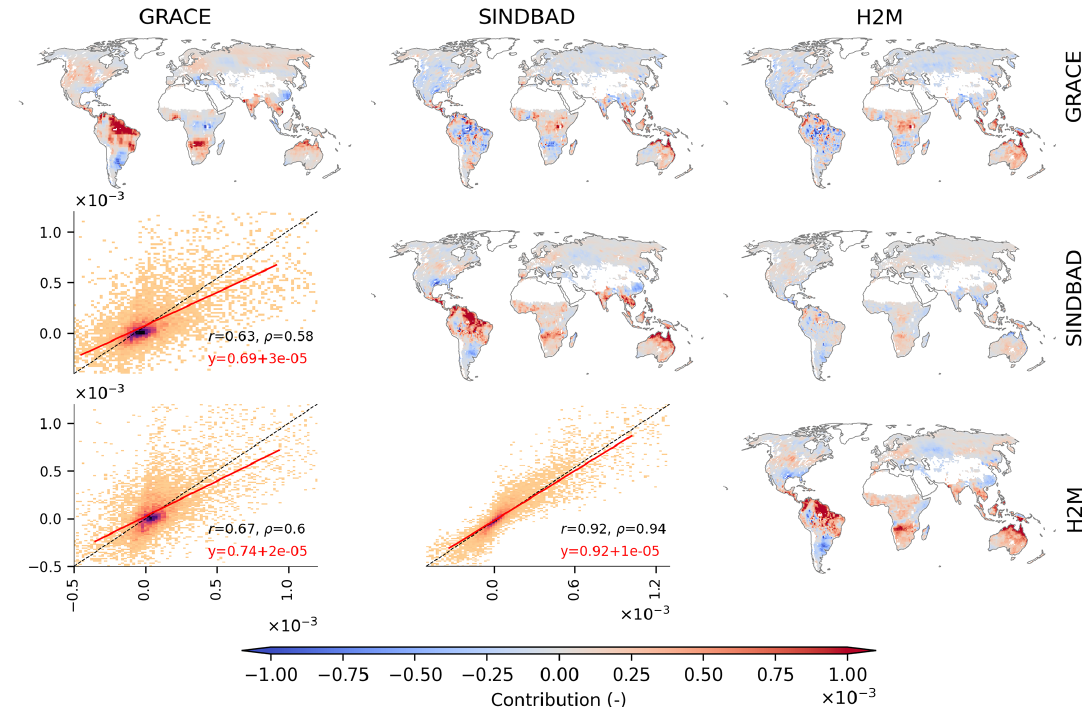
Figure B20. Same as Fig. 3 but using MSWEP instead of GPCP1dd for the precipitation forcing.